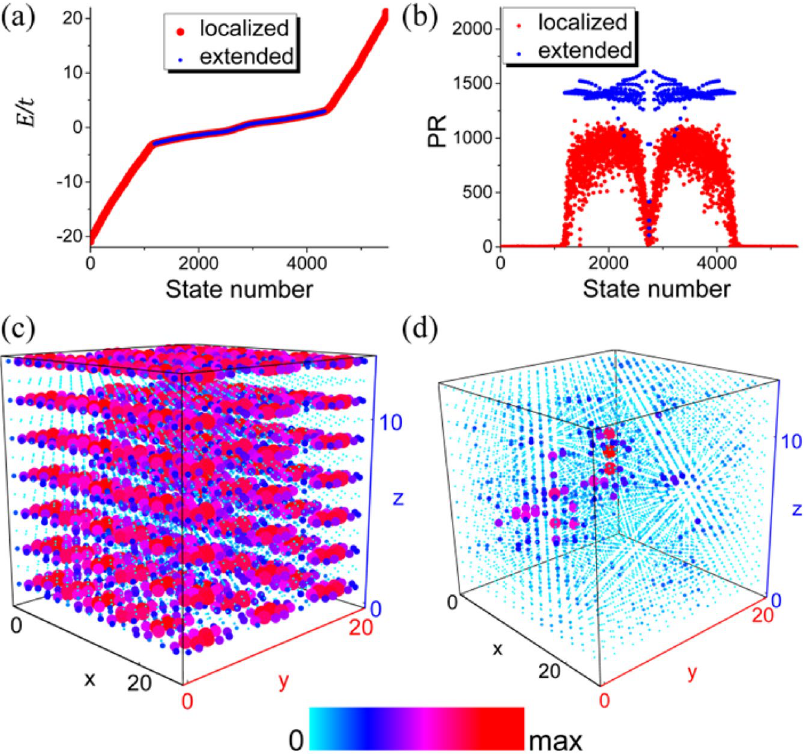
Figure 3. ( a ) The coexistence of extended states and localized states in the energy spectrum of a system consisting of multiple honeycomb layers, where diagonal disorder is added to alternating layers. ( b ) The participation ratios of all the eigenstates. ( c ) and ( d ) show two states with the same eigen-energy E / t = 2.51, one is extended and the other is